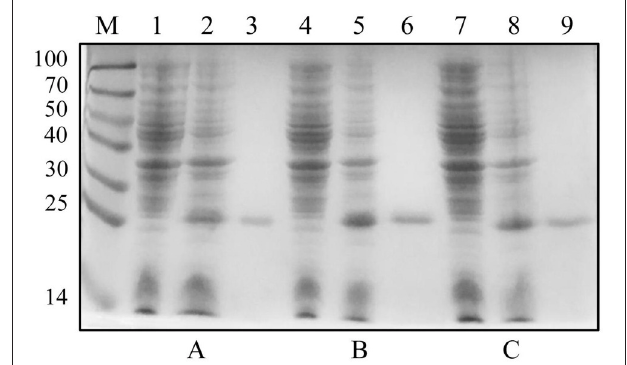
FIGURE 7 | Expression and purification levels of recombinant three C1q domains. (A–C) show expression and purification levels of C1q1, C1q2, and C1q3. Lane M, protein marker; lanes 1, 4, and 7, crude protein extracts of E. coli without induction; lanes 2, 5, and 8, crude protein extracts of E. coli with IPTG induction; lanes 3, 6, and 9, purified recombinant proteins by His-Bind resin chromatography.